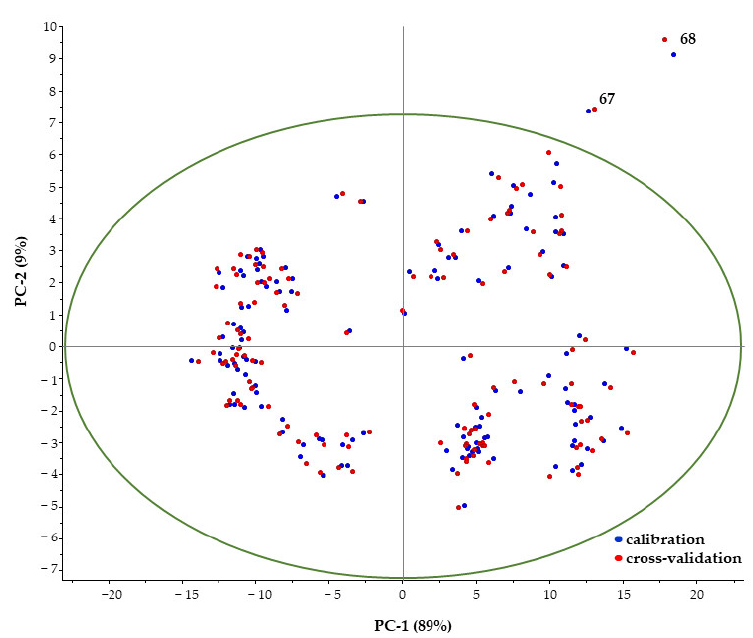
Figure 2. PCA analysis.